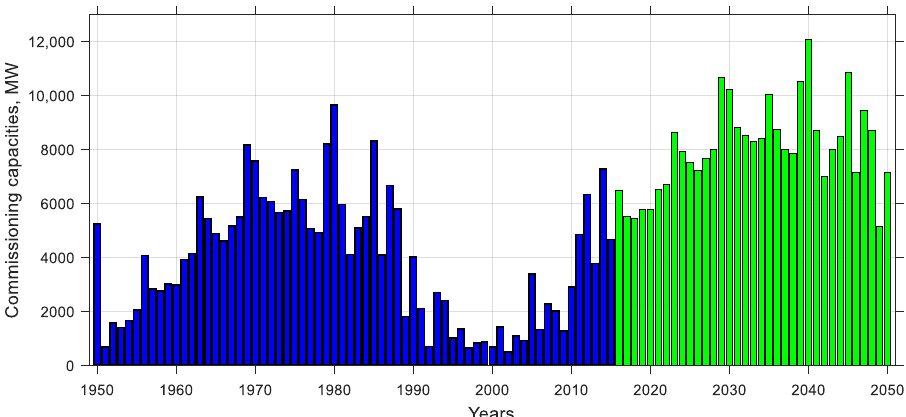
Figure 1. The dynamics of commissioning of capacities of the EPS of Russia in prehistory (1950 – 2015) and the forecasting period (2016 – 2050), obtained using model 1.